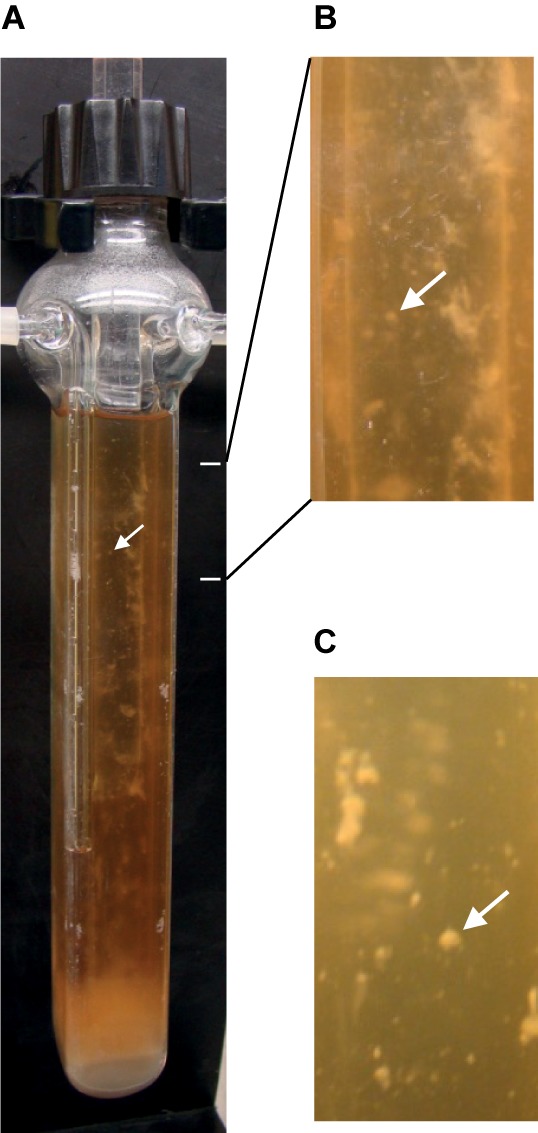
Biofilm of strain 630Δerm after growth in a continuous-flow micro-fermentor. After anaerobic growth for 72 h in TYt medium, macro-colonies and biofilms can be observed on micro-fermentor walls. The medium is clear, as expected in the absence of planktonic growth. A representative picture of independent experiments is shown (A). Magnifications (B,C) allow observing macro-colonies (arrows).